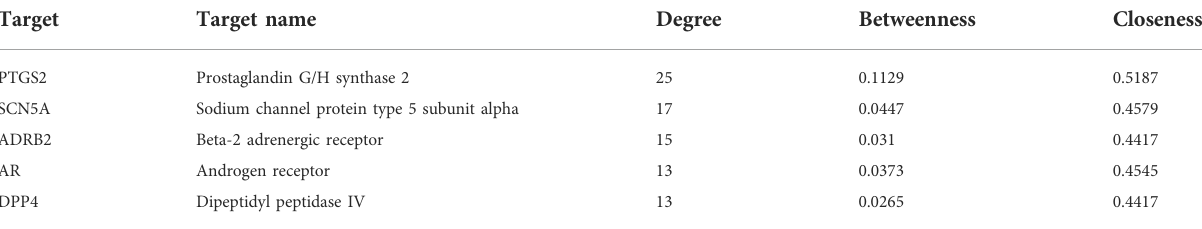
TABLE 5 The node characteristic parameters of the main targets in the compound-target network.